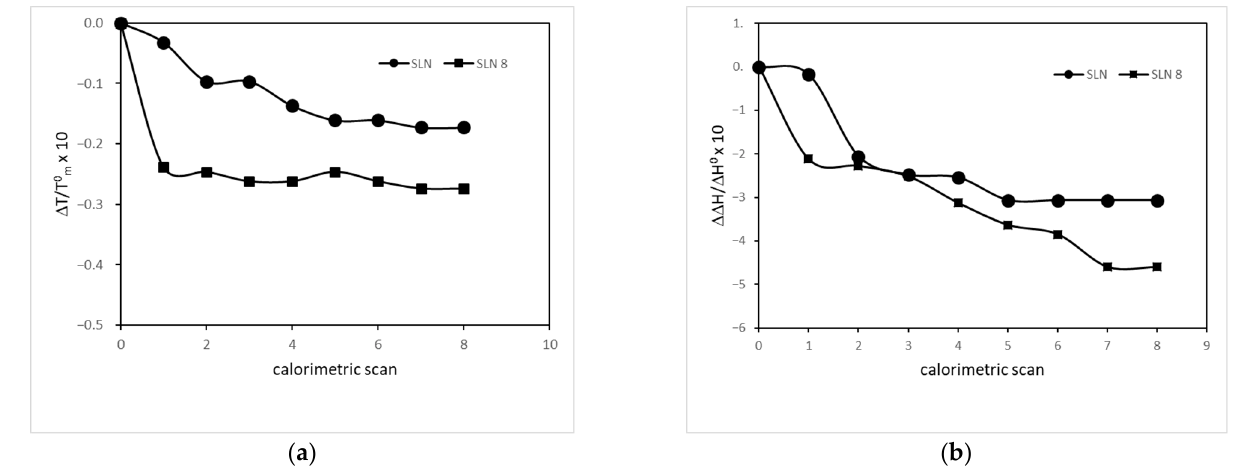
Figure 7. ( a ) Transition temperature variation of MLV left in contact with SLN and SLN 8, as a function of the calorimetric scans. There are a 68 min between one scan and the next. The transition temperature variation is reported as Δ Τ /T 0m ( Δ Τ = T m − T 0m , where T m is the transition temperature of the MLV left in contact with SLN or SLN 8 and T 0m is the transition temperature of MLV. ( b ) Transition enthalpy variation of MLV left in contact with SLN and SLN 8, as a function of the calorimetric scans. There are 68 min between one scan and the next. The transition enthalpy variation is reported as ΔΔ H/ Δ H 0 ( ΔΔ H = Δ H − Δ H 0 , where Δ H is the transition enthalpy variation of the MLV left in contact with SLN or SLN 8 and Δ H 0 is the transition enthalpy variation of MLV).